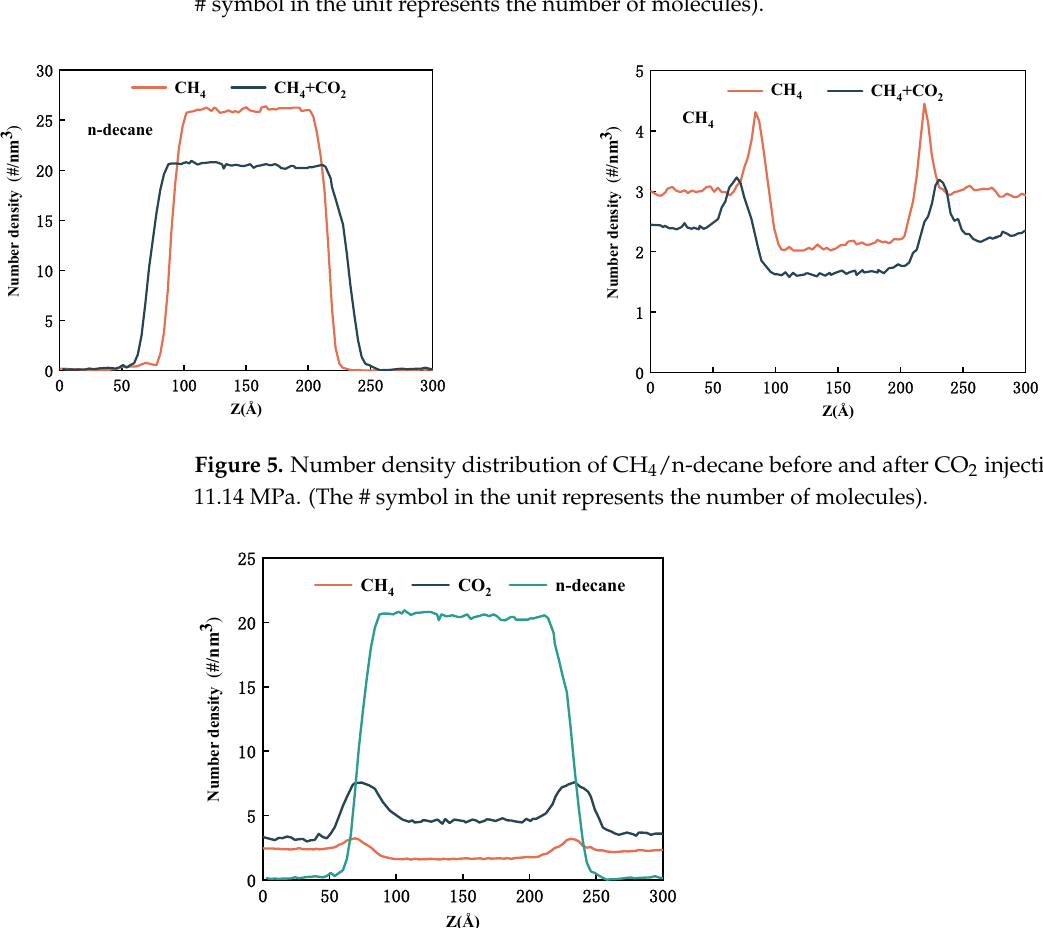
Figure 6. Number density distribution of CH 4 /CO 2 /n-decane at 313.3 K,11.14 MPa. (The # symbol in the unit represents the number of molecules).